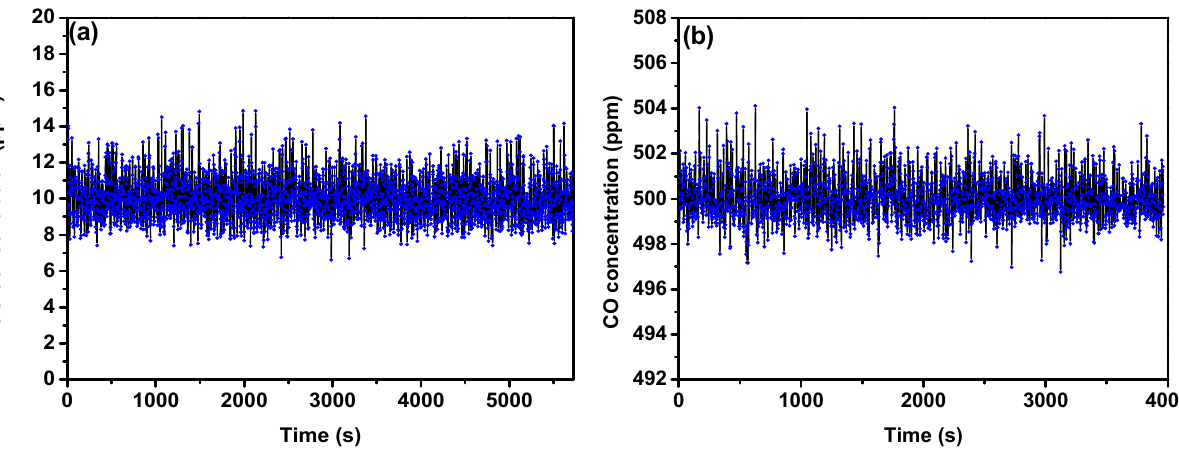
Figure 7. Long-term stability of the compact and low-power-consumption CO sensor ( a ) 10 ppm CO; ( b ) 500 ppm CO.